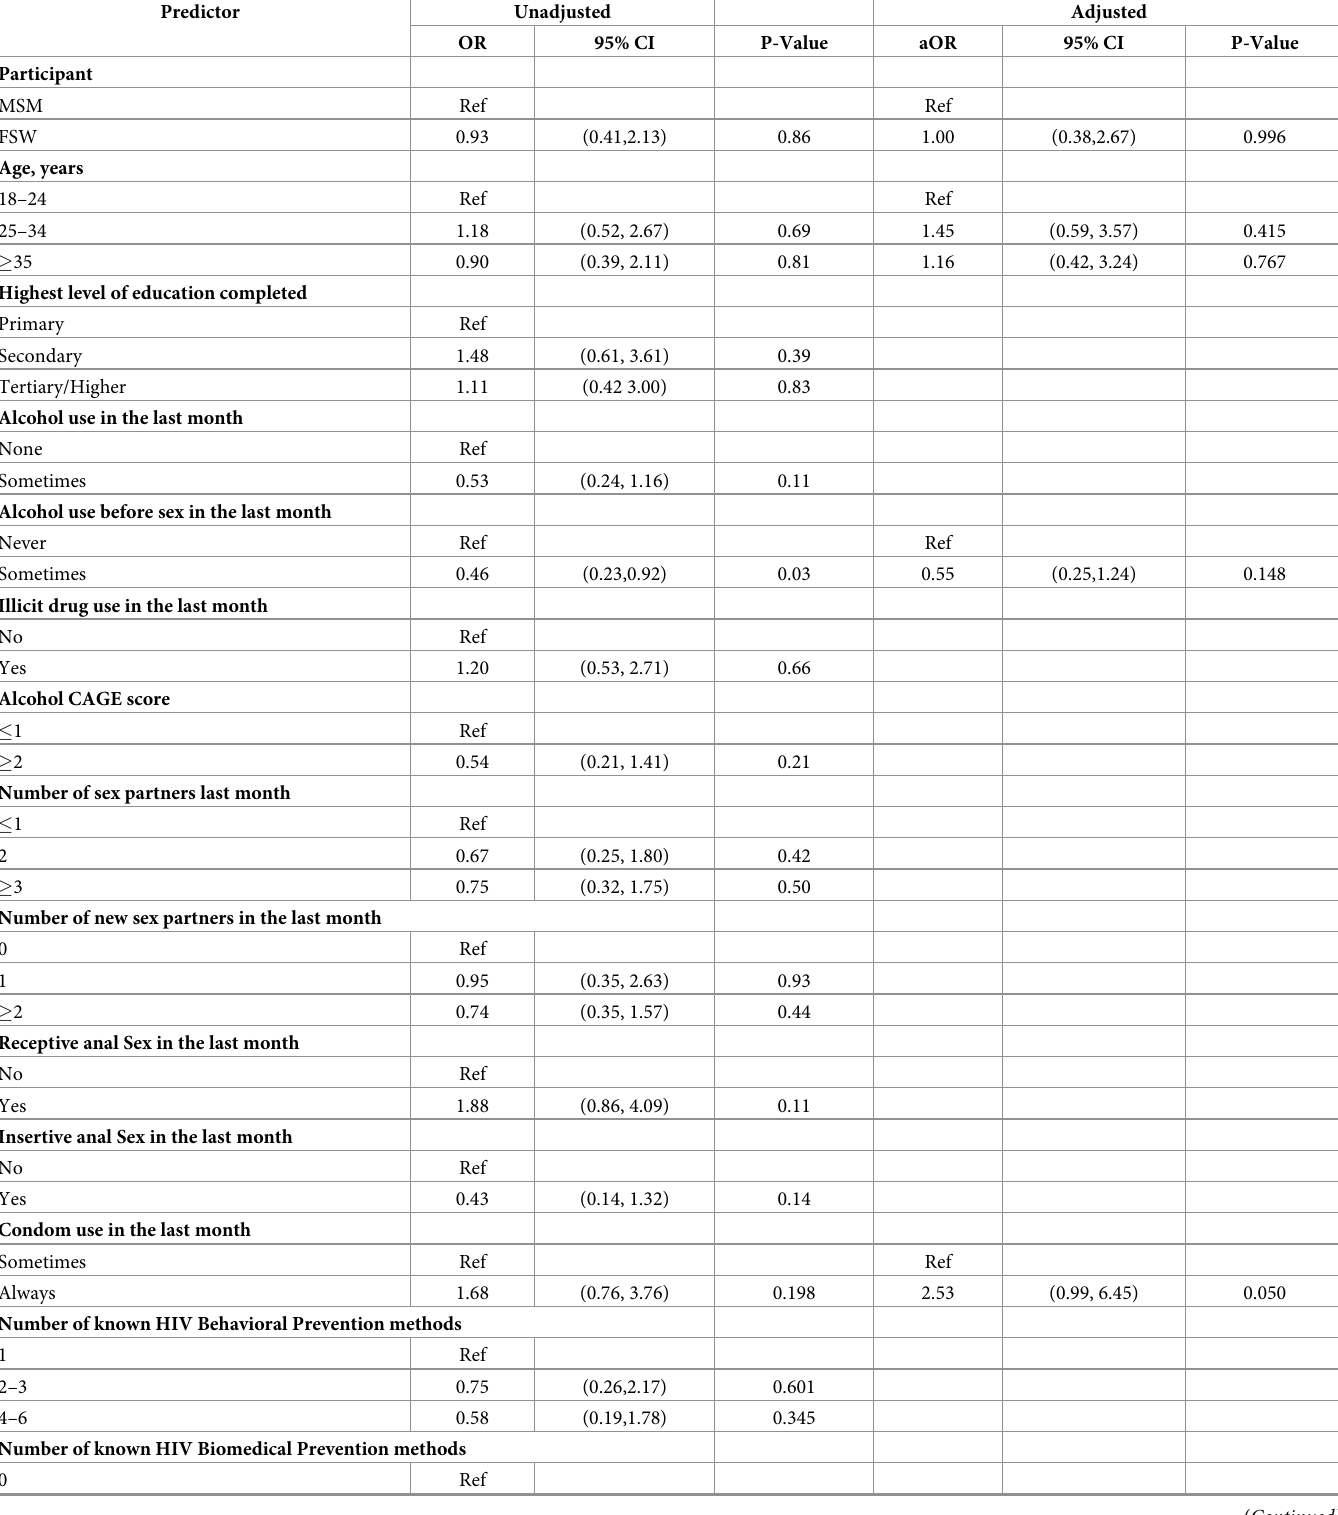
Table 2. Predictors of willingness to participate in future HIV vaccine trial among the 214 participants in a simulated vaccine